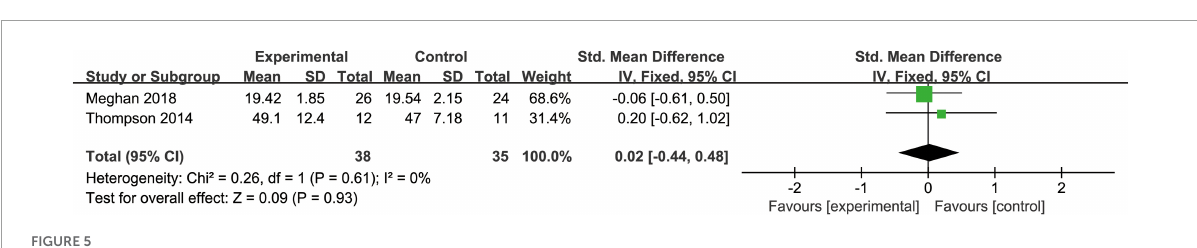
FIGURE5 Forest plots of the MT (vs. no-MT) effect on social adaptation. SD: standard deviation; 95% CI: 95% confidence interval; IV: inverse variance method.